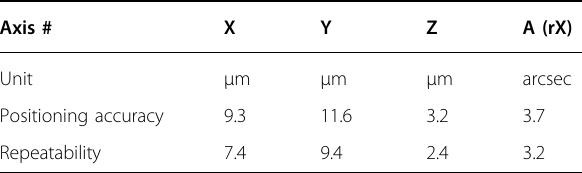
Table 3 Axial precision of the 4.5 m MRF polishing machine Axis # X Y Z A (rX) Unit μ m μ m μ m arcsec Positioning